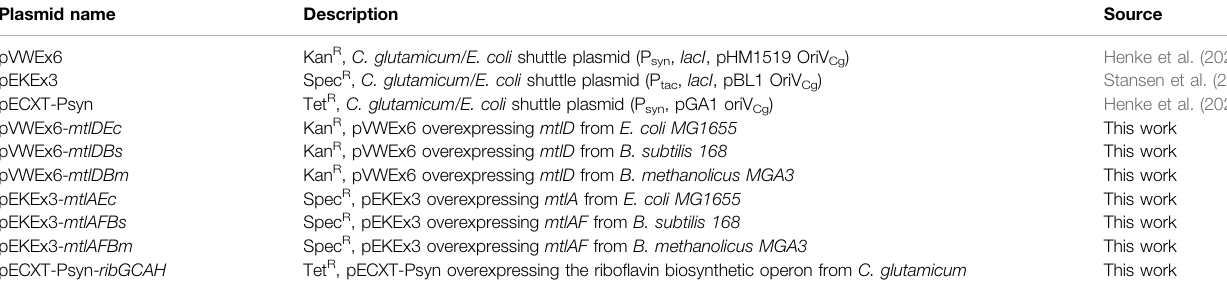
TABLE 1 | List of plasmids used in this work. Kan R , kanamycin resistance; Spec R , spectinomycin resistance; Tet R , tetracycline resistance. Plasmid name